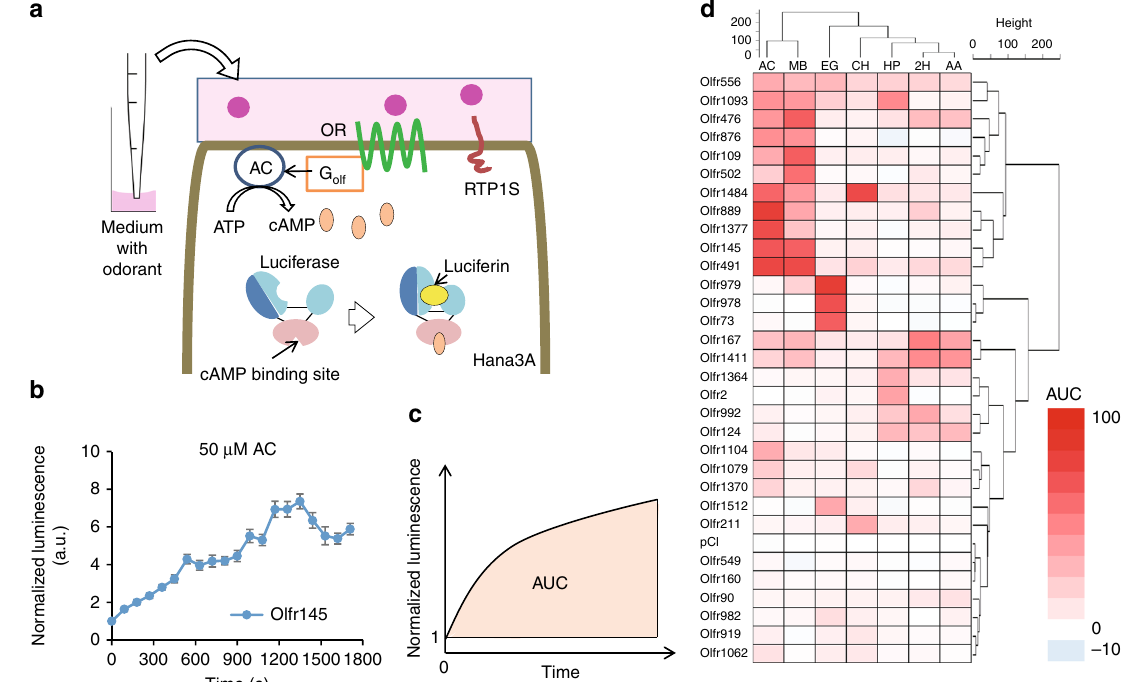
Fig. 2 Liquid-phase odor stimulation with GloSensor assay system. a A schematic diagram of GloSensor assay in Hana3A showing OR signal transduction pathway. The GloSensor system use a modi fi ed luciferase with a cAMP binding domain so that luminescence activity depends on cAMP. b Real time measurement of each OR activation with 50 μ M acetophenone. Error bars indicate s.e.m. ( n = 3). c The image of area under the curve (AUC) analysis. Here, AUC indicates the sum of normalized luminescence from initial response to fi nal response. d The heat map based on AUC with 50 μ M acetophenone stimulation. The number on the left side indicate each OR and pCI (vector control) with a hierarchical clustering analysis. AC adenylyl cyclase, ATP adenosine triphosphate, cAMP cyclic monophosphate, RTP1S receptor transporting protein 1 short